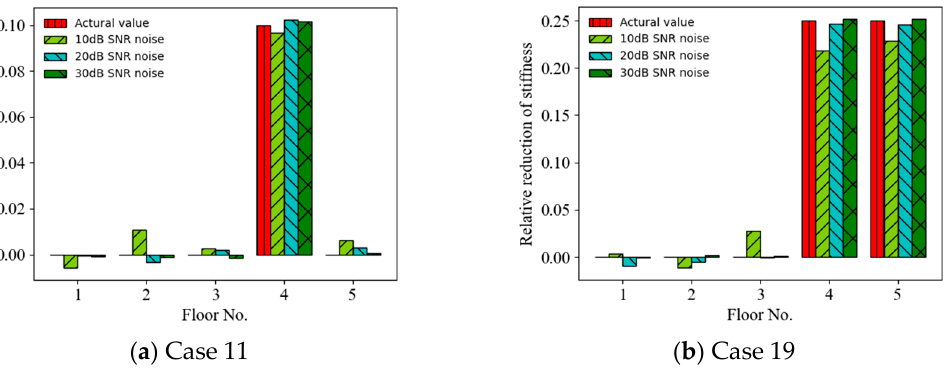
Figure 6. Mean prediction results of structural anomaly using displacement responses as ANN input for noise intensities.